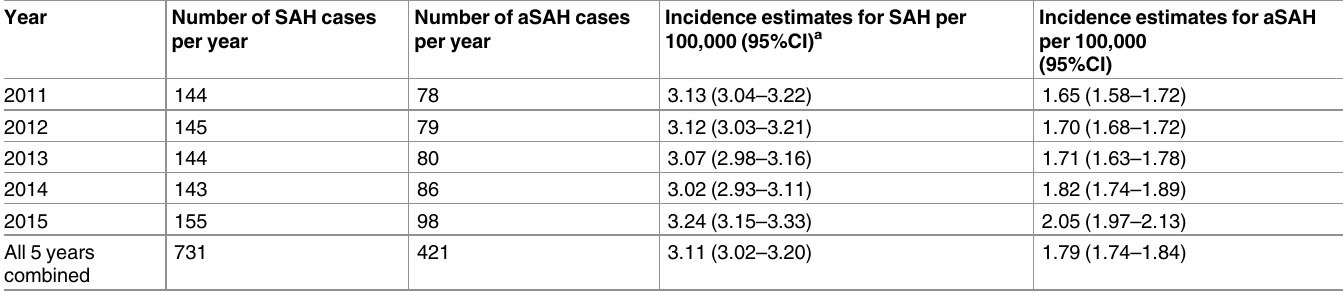
Table 1. Incidence estimatesfor SAH and aSAH in 2011–2015in Fars, Iran.